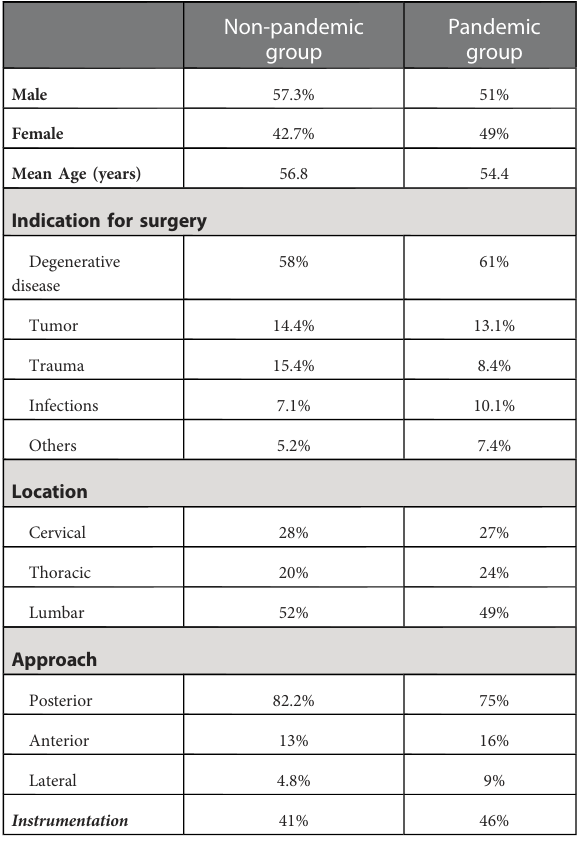
TABLE 1 Comparison of the patient samples of the two periods.